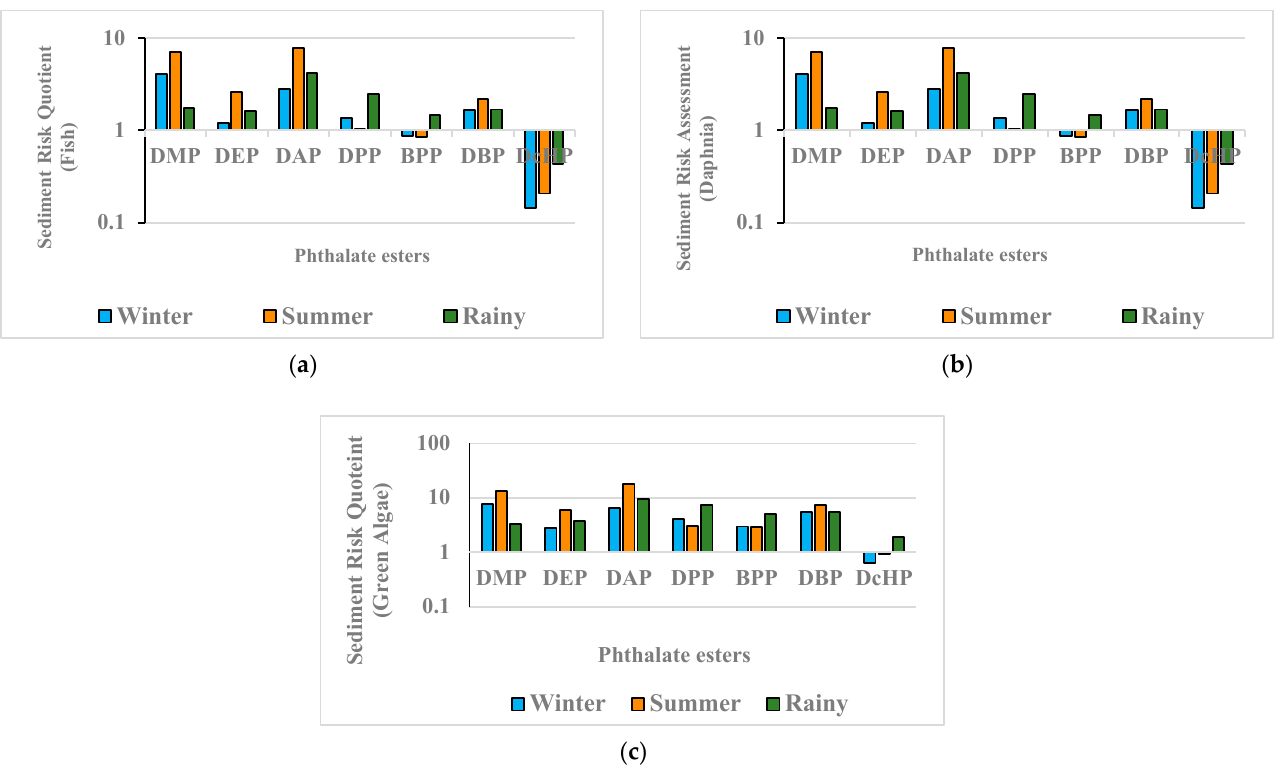
Figure 7. Aquatic risk assessment ( a ) Exposure of phthalates in fish of sediment samples for different seasons; ( b ) Exposure of phthalates in daphnia of sediment samples for different seasons; ( c ) Exposure of phthalates in green algae of sediment samples for different seasons.